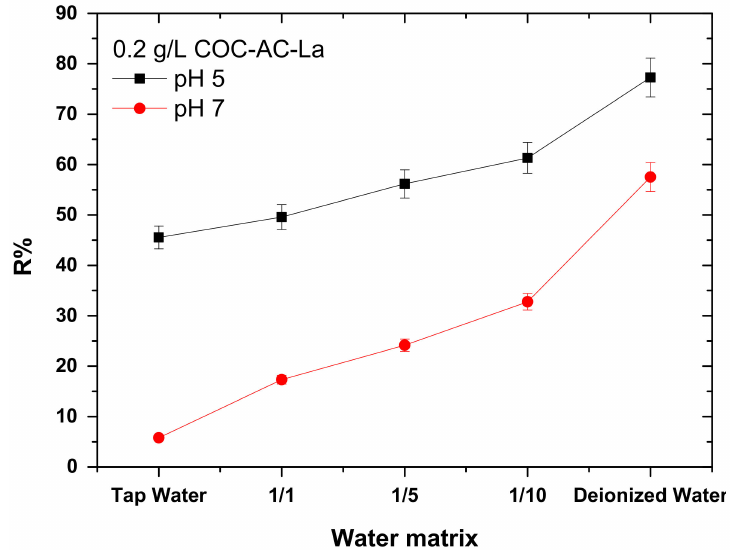
Figure 10. Effect of water matrix on the adsorption of Cr(VI) on COC-AC-La; initial Cr(VI) concentra- tion 100 µ g/L, solution pH 5 and 7, dose 0.2 g/L, T = 22 ± 1 ◦ C, contact time 24 h, in deionized water.